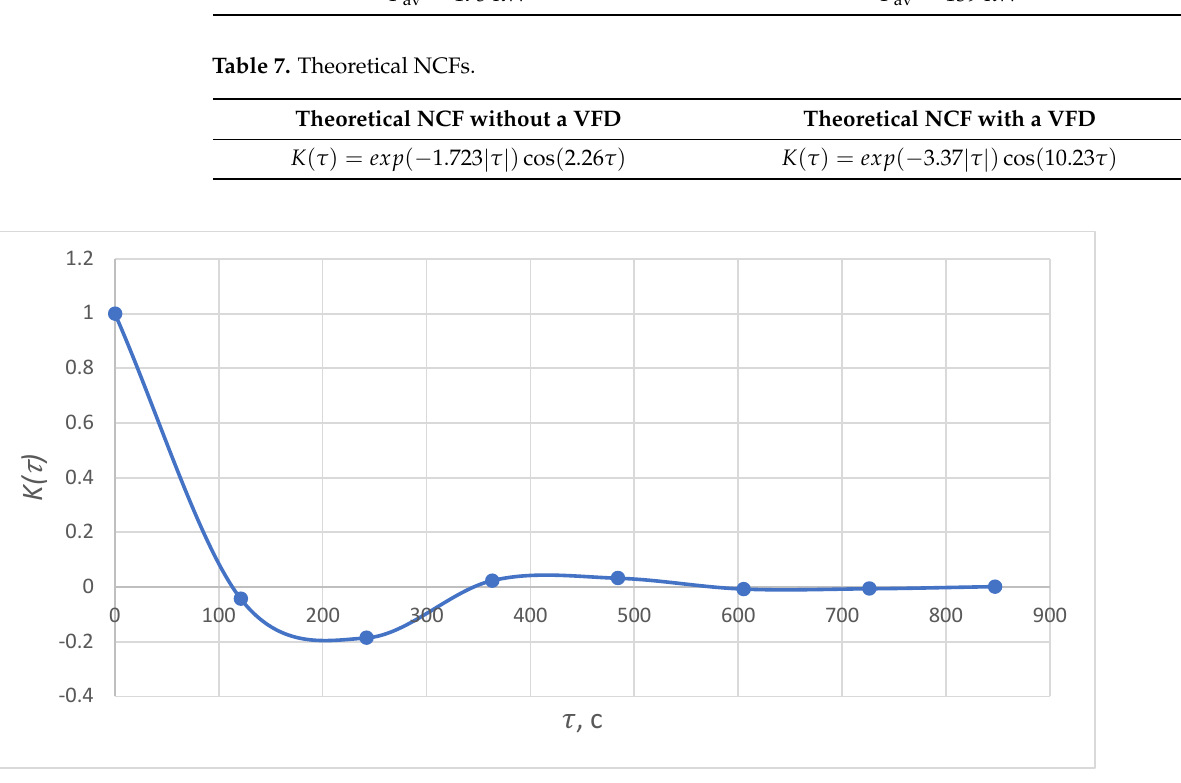
Figure 3. Theoretical NCF curve without a VFD. Figure 1. Theoretical NCF curve without a VFD.